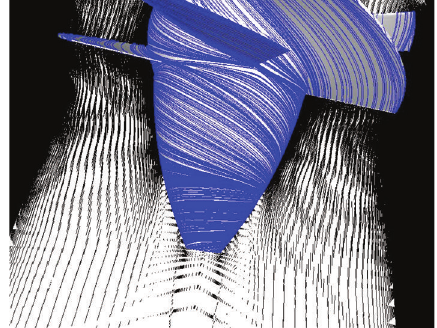
Figure 11: Smearlines and velocity vectors for 62rad / s.